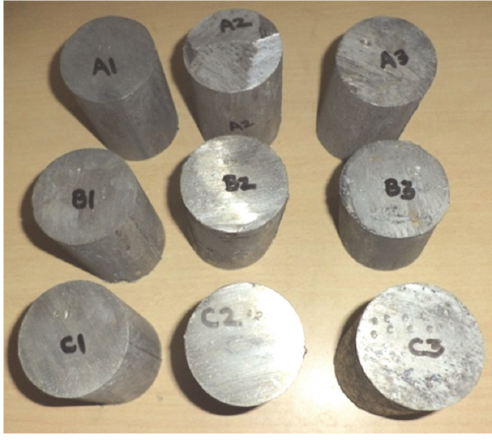
Fig. 1. Heat treated MMC